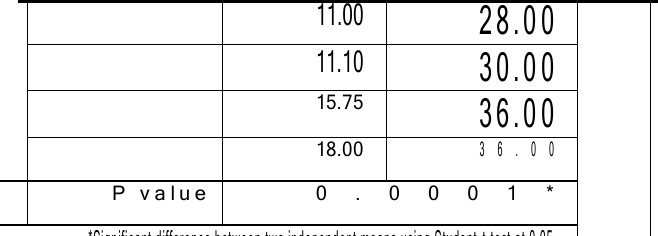
*Significant difference between two independent means using Student-t-test at 0.05.